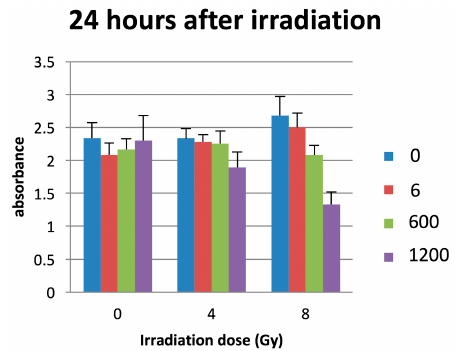
Figure 7. The combination of PCSN probes (PCSN concentration: 1200 ppm) and 8-Gy irradiation resulted in the lowest absorbance 24 h after irradiation. The numbers (0, 6, 600, 1200) indicate the concentration of PCSN (ppm). The y -axis represents the absorbance unit (450 nm). Quantifying cell viability for seven days after the cells were seeded revealed that the combination of PCSN probes and radiation (1200 ppm and 8 Gy, respectively) promoted and induced cell death (Figure 8). Terminal deoxynucleotidyl transferase (dUTP)-mediated nick end-labeling (TUNEL) assays showed that maximum apoptosis was induced by the combination of radiation and PCSN probes (Figures 9 and 10). Fluorescent-labeled inhibitor of caspases (FLICA) assays showed